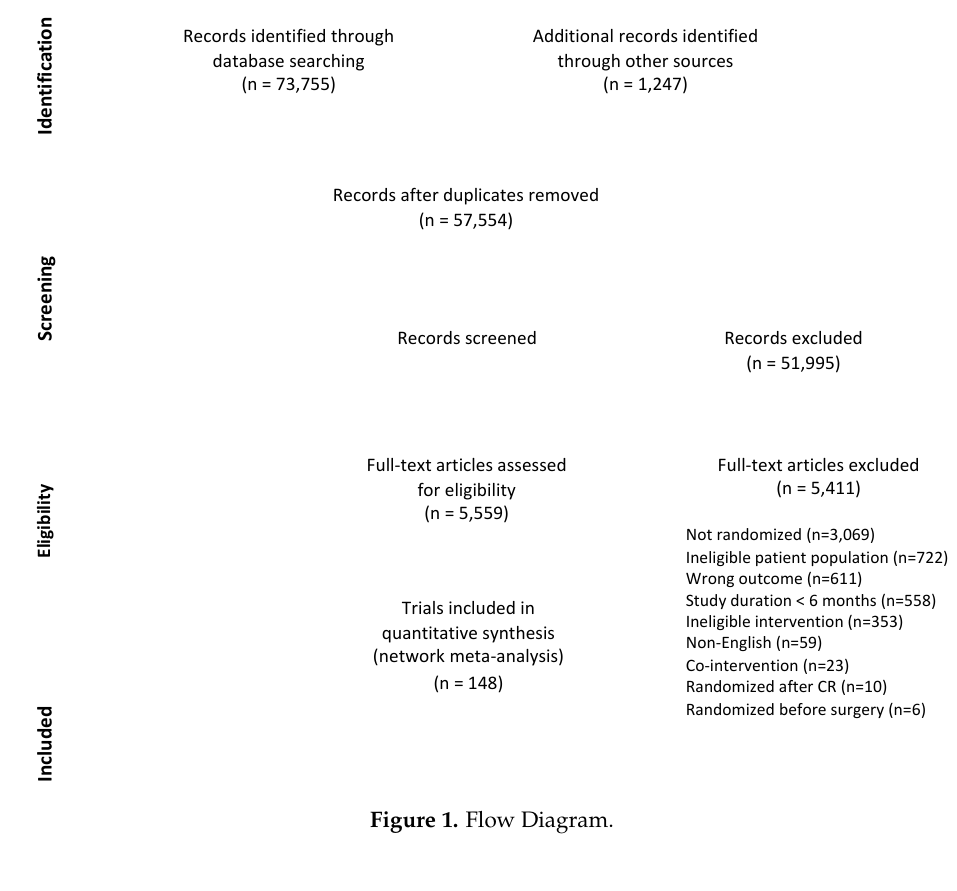
Figure 1. Flow Figure 1 Flow Diagram.